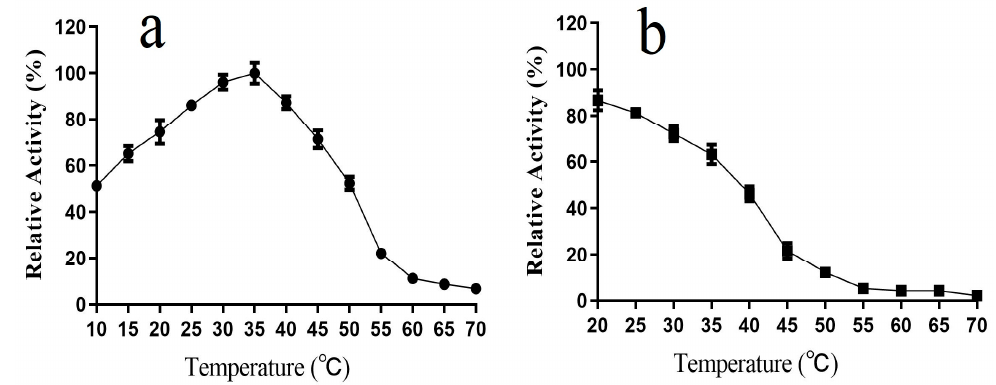
Figure 4. ( a ) Effect of temperature on L01 catalytic activity; ( b ) effect of temperature on L01 stability Figure 4. ( a ) E ff ect of temperature on L01 catalytic activity; ( b ) e ff ect of temperature on L01 stability after 2 h of incubation ( n = after 2 h of incubation ( n = 3).